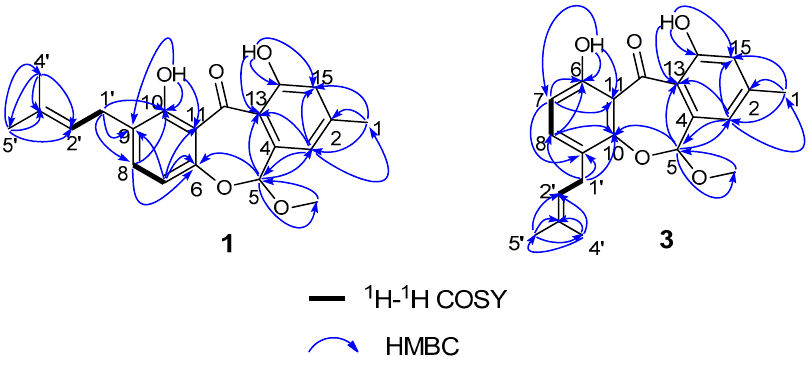
Figure 2. Key 1 H- 1 H COSY and HMBC correlations of 1 and 3 .